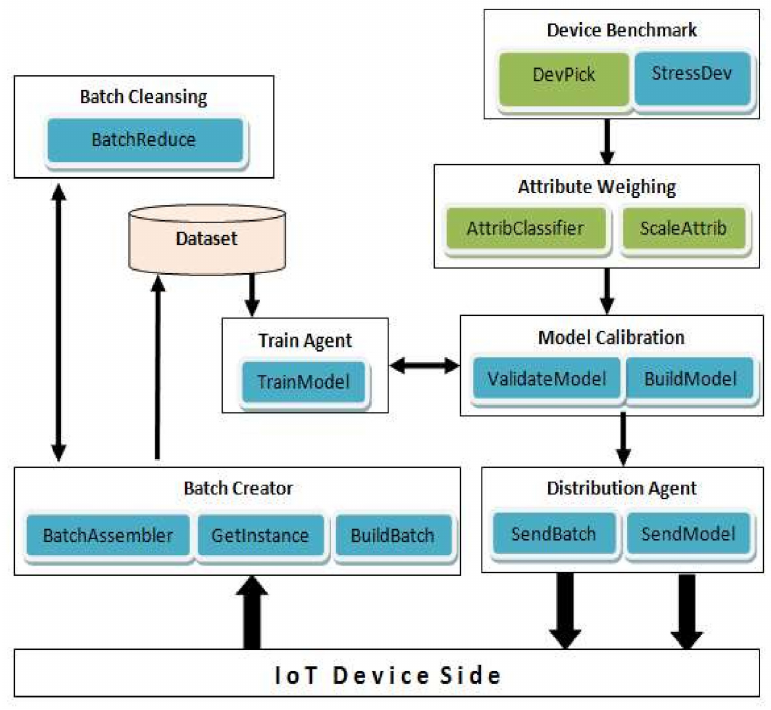
Figure 2. Cloud MaaS Functional